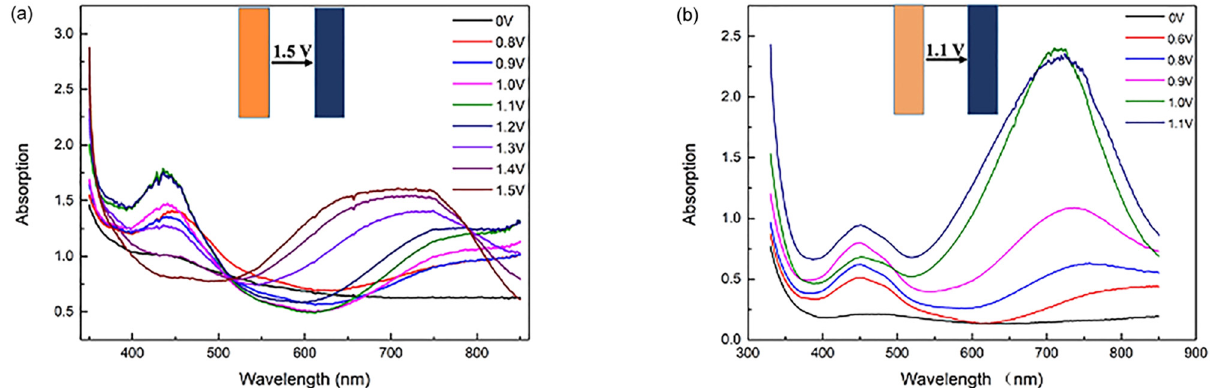
Figure 5: Electrochromic curves at increasing potentials: ( a ) P ( TTF - Th ) and ( b ) P ( DTTF - Th )